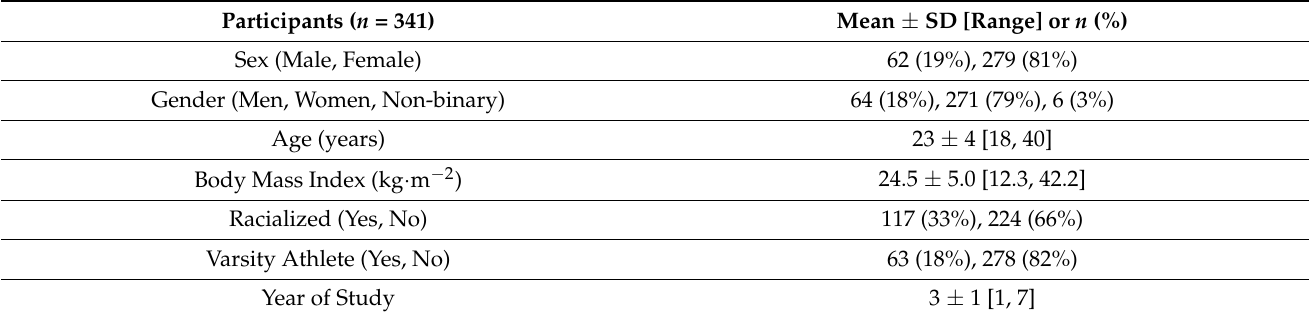
Table 1. Self-reported sample characteristics for 341 undergraduate students from